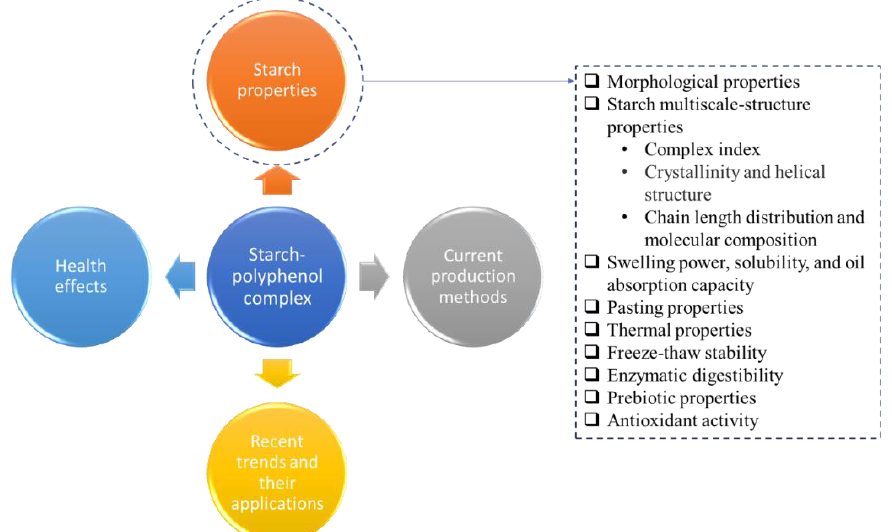
Figure 1. Graphical outline of the information contained in this review.